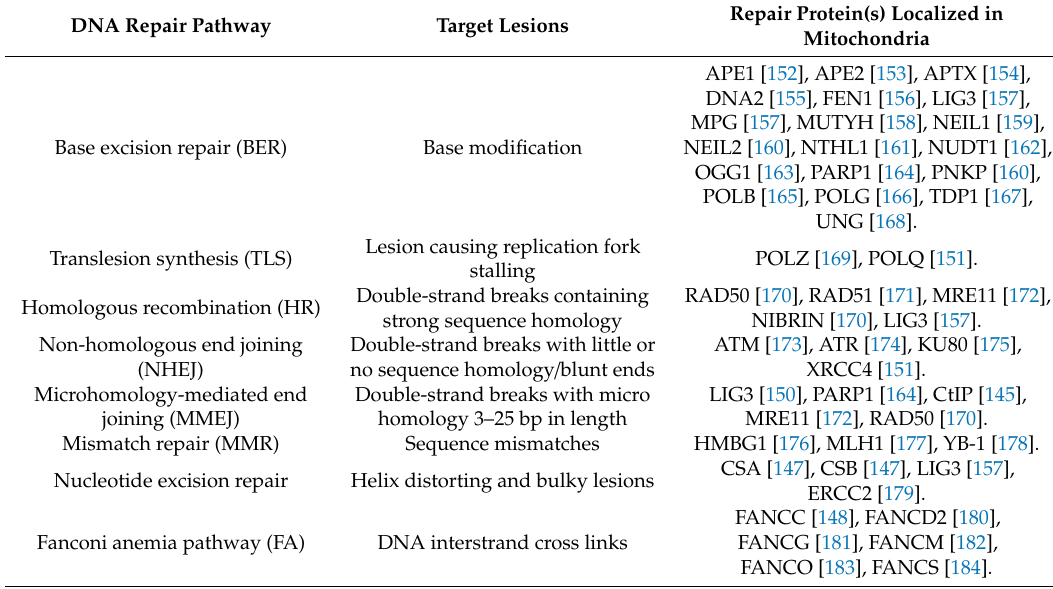
Table 1. DNA repair proteins and their associated pathways reported to be localized in mitochondria. DNA Repair Pathway Target Lesions